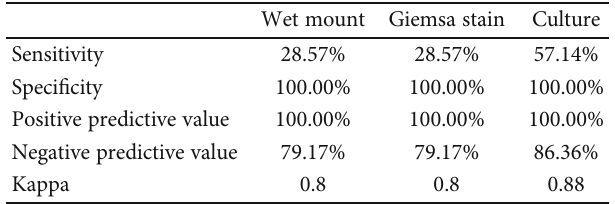
Table 3: The diagnostic performance of the used diagnostic